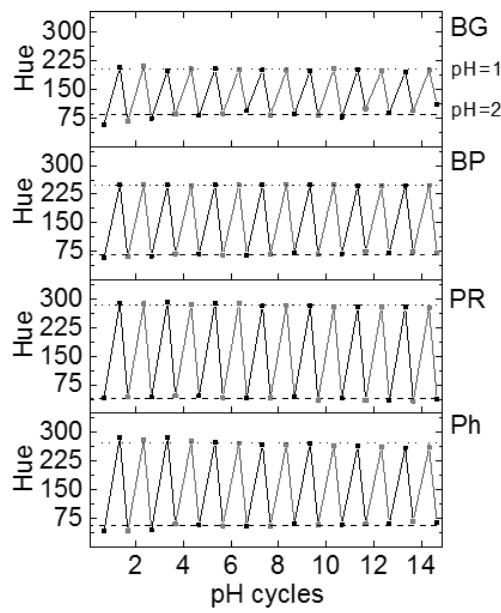
Figure 6. Hue values at pH 2 and pH 12 for 14 cycles of passing through the sensing areas using an acidic solution followed by a basic solution. The Hue values were obtained after 2 min stabilisation time. The dashed and dotted lines indicate the average of the Hue values from all of the cycles for each sensor at pH 2 and 12, respectively.